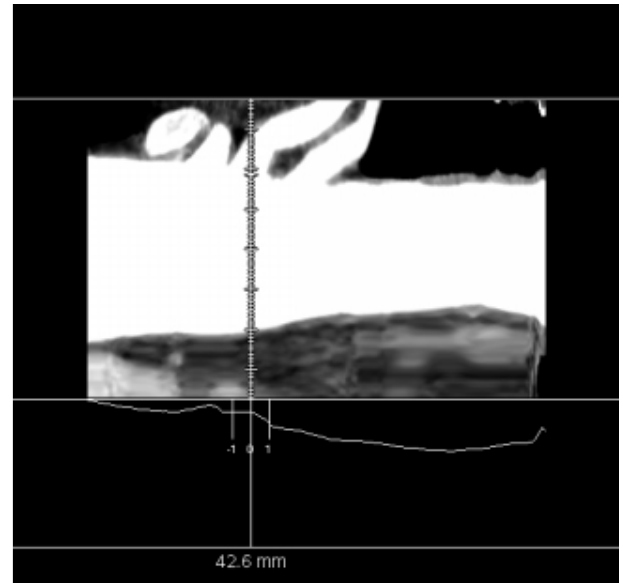
Fig. 2 - The aortic arch was straightened with the center line tool. The three branches of the aorta were observed in the image side view. The center point of the three branches was selected to define the center of a cross